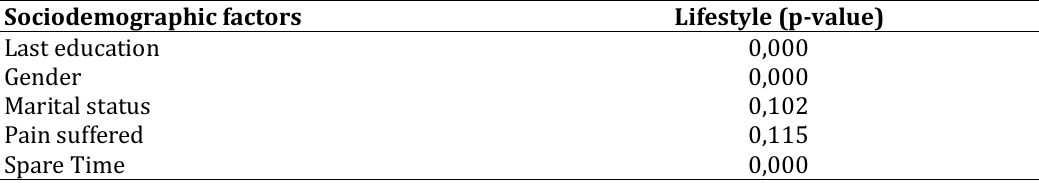
Chi-square analysis of sociodemographic factors on a passive lifestyle Sociodemographic factors